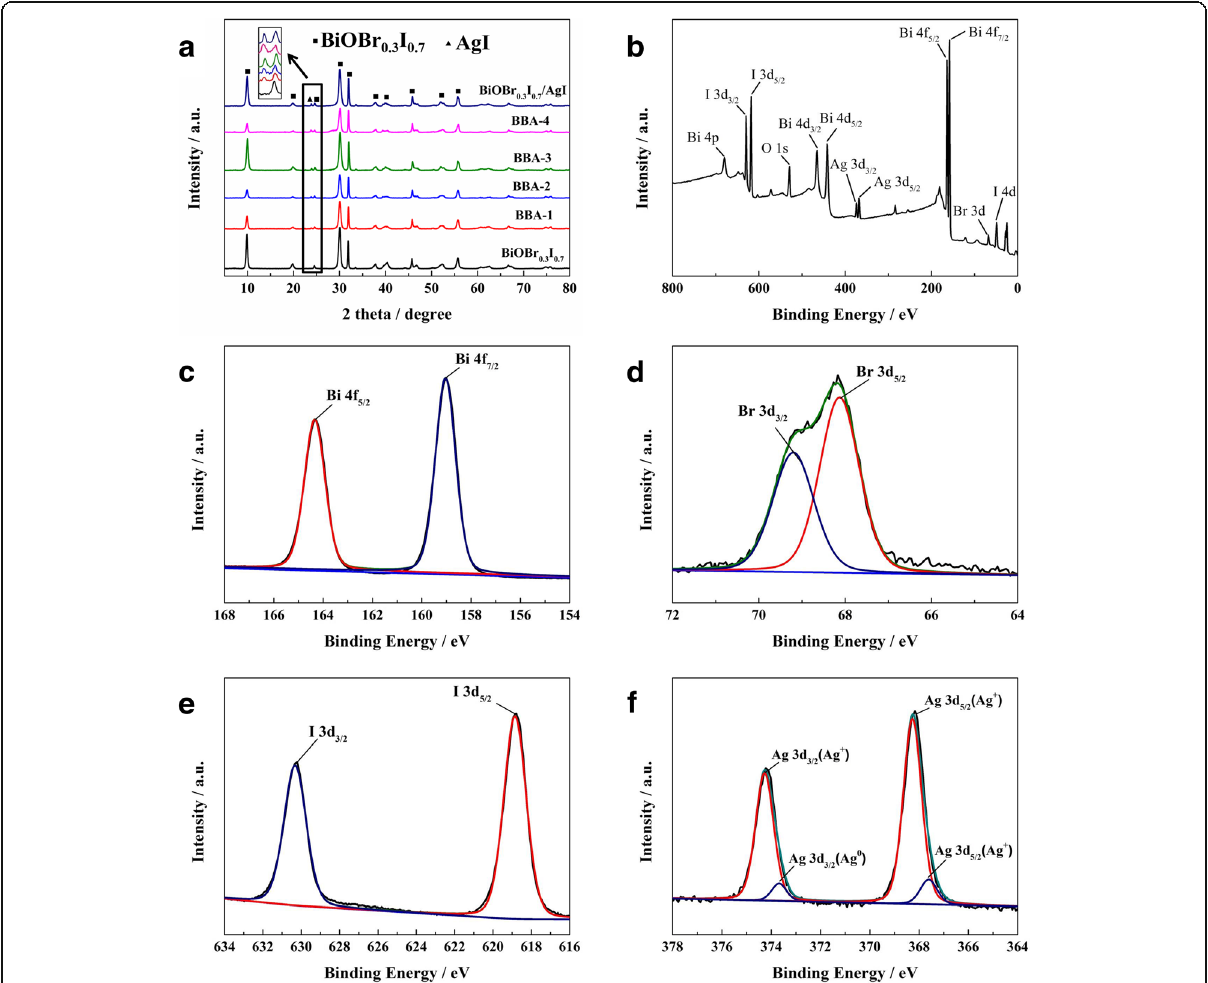
Fig. 1 XRD patterns of BiOBr 0.3 I 0.7, BAA-x and BiOBr 0.3 I 0.7 /AgI ( a ), XPS survey spectra of BAA-15 ( b ), BAA-15 XPS spectra of Bi 4f ( c ), Br 3d ( d ), I 3d ( e ), and Ag 3d ( f